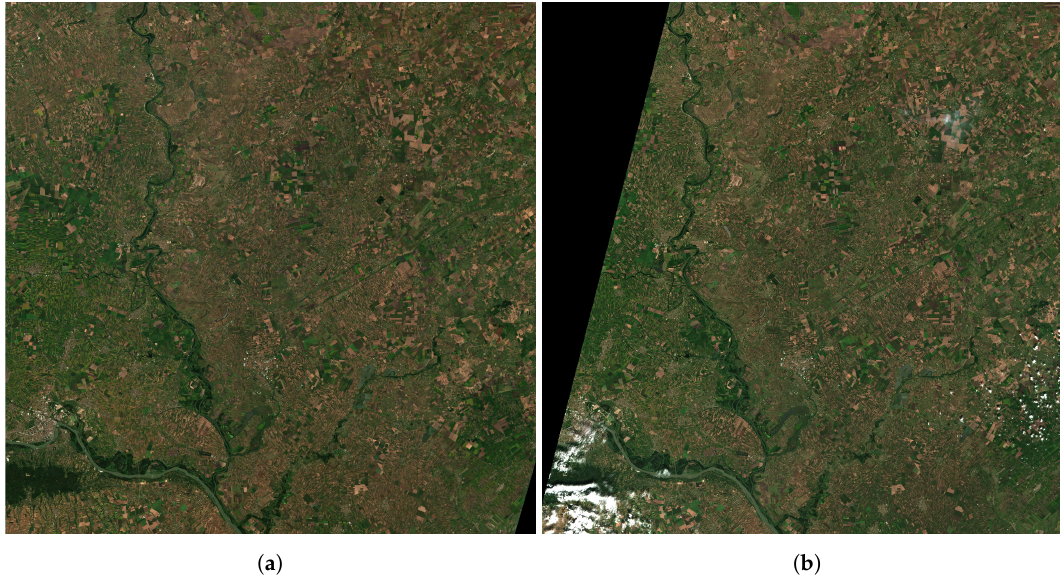
Figure 4. Degree of spatial overlap between two adjacent Sentinel-2A relative orbits, ( a ) R036 and ( b ) R136. Shown 20 m images were acquired on 28th and 25th August 2016, as parts R036 and